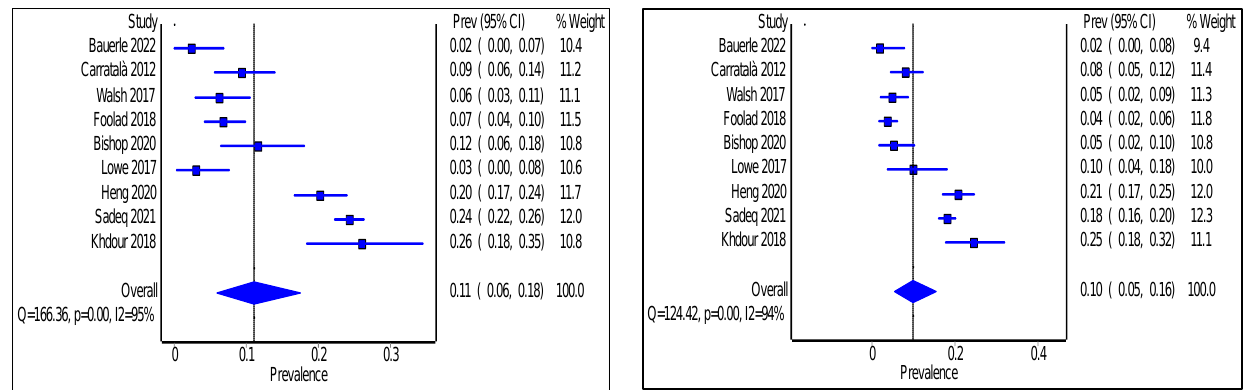
Figure 5. Prevalence of 30-day readmission within the inpatient setting in non-intervention and intervention